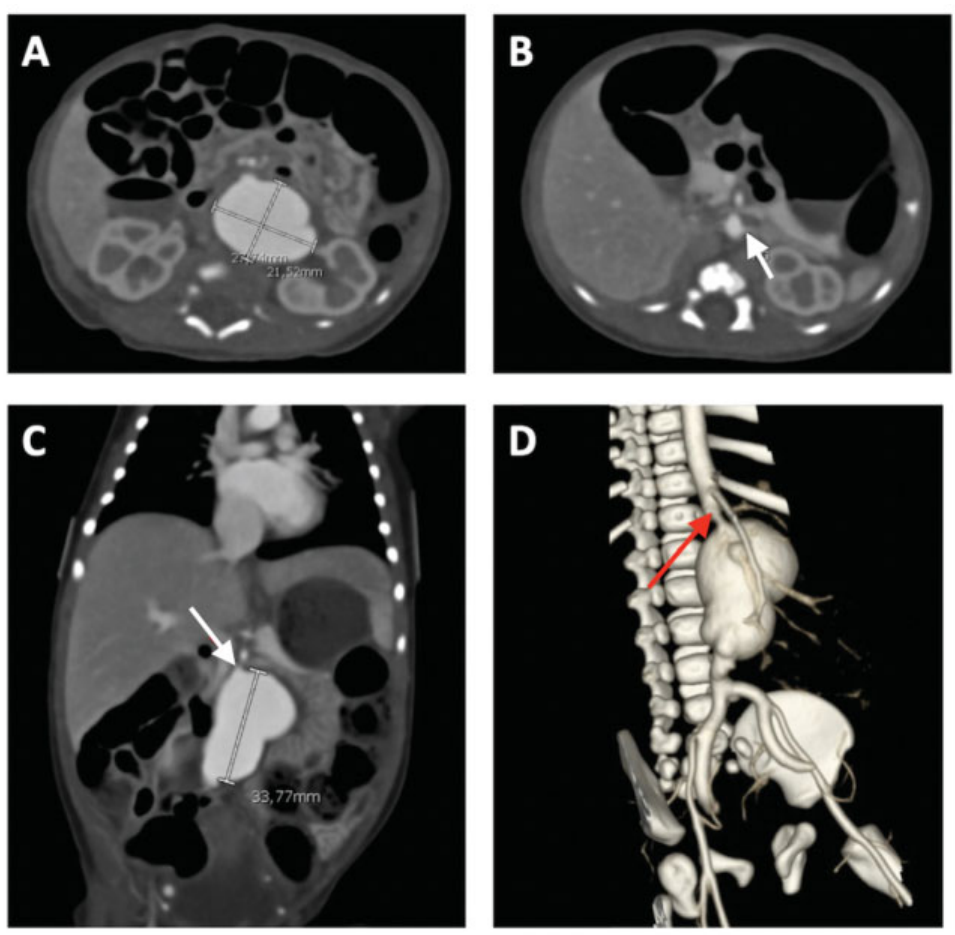
Fig. 1 Initial computed tomography angiogram of chest, abdomen, and pelvis. Images ( A – C ) reveal a 2.8 (cid:3) 3.3 (cid:3) 2.2-cm congenital abdominal aortic aneurysm. Image ( D ) shows a three-dimensional reconstruction. Redarrows inimages( C, D ) denotethe proximal 2-mm stenosis, whilethe white arrow in image ( B ) denotes the left renal artery. European Journal of Pediatric Surgery Reports Vol. 9 No. 1/2021 © 2021. The